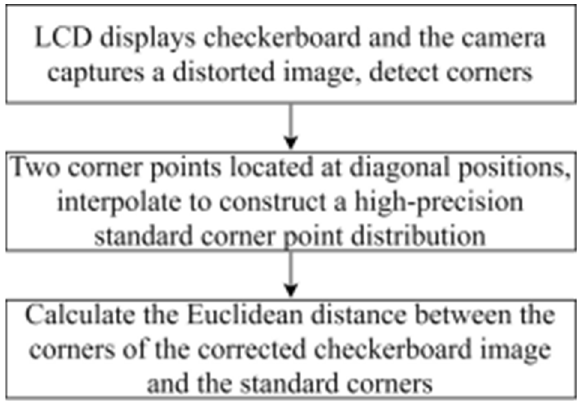
Figure 8. The process of quantitative evaluation.